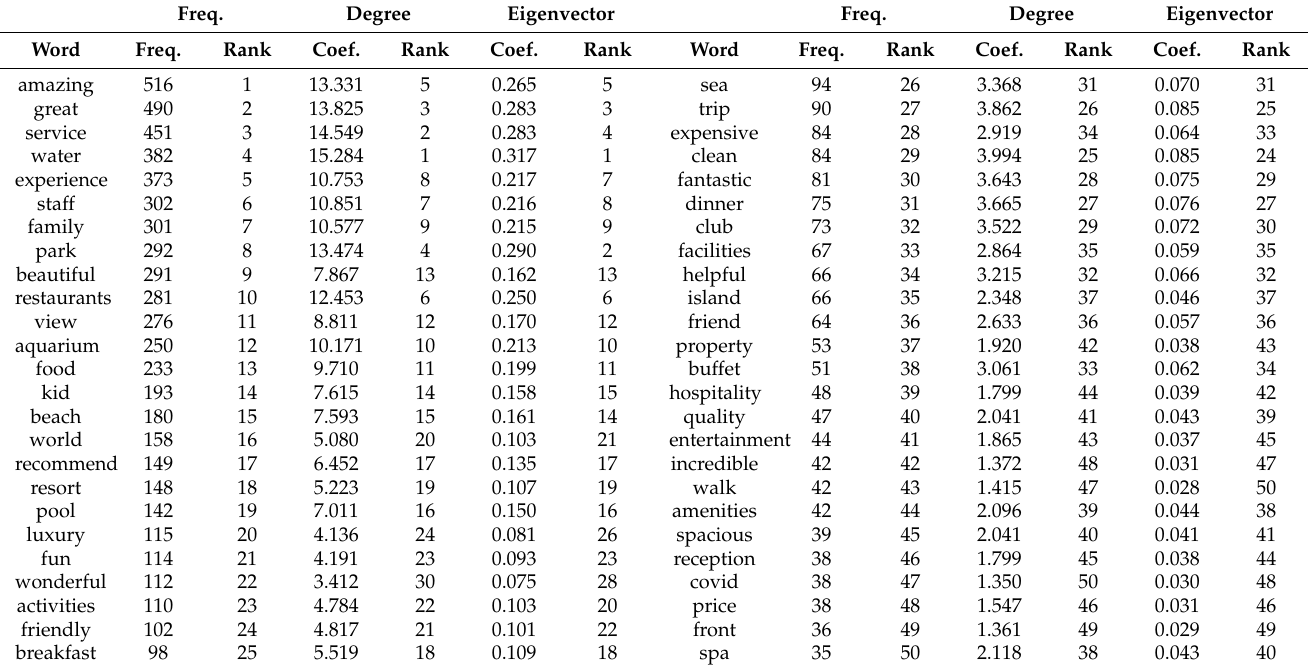
Table 2. Comparison of keyword frequency and centrality analysis.